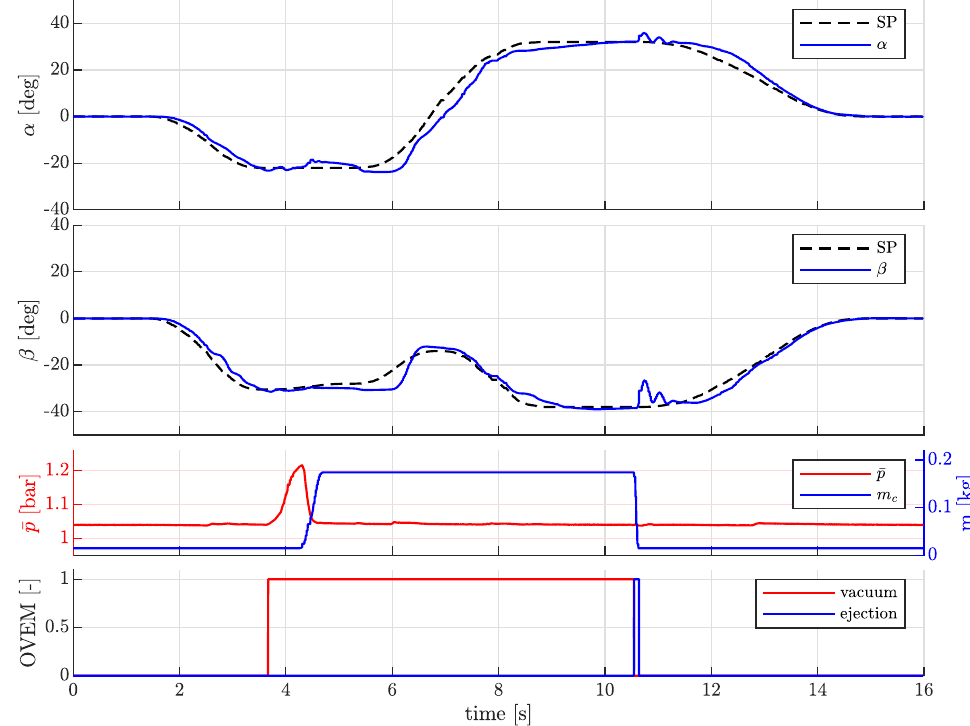
Figure 18. A visualization of the pick and place application: The top two plots show the angles α and β and their setpoints, respectively. The arm starts from the idle position, ( α , β ) = ( 0°,0° ) , and picks up the object at the location, ( − 22°, − 30.5° ) , moves it to the target location at ( − 32°, − 38° ) , and then moves back to the idle location ( 0°,0° ) . The arm is raised in the positive β -direction between picking the object and releasing it, to avoid interfering with the platforms where the object is picked from and released to. Releasing the object causes an error in both angles due to the sudden change of mass. The third plot shows the lower actuator pressure level, ¯ p , and the load mass assumed by the controller. When the suction cup points towards the object, the lower actuator pressure level is increased to cause a longitudinal elongation and pick up the object. The payload mass commanded to the controller is continuously increased from the weight of the suction cup to the combined weight of suction cup and manipulated object. When the object is released, the commanded mass is continuously decreased back to the weight of the suction cup. The bottom plot shows the control inputs of the vacuum generation unit. The red curve shows the vacuum input to generate a vacuum at the suction cup. It is activated shortly before the suction cup touches the object to ensure a reliable picking procedure. The blue curve shows the ejection impulse used to release the vacuum when placing the